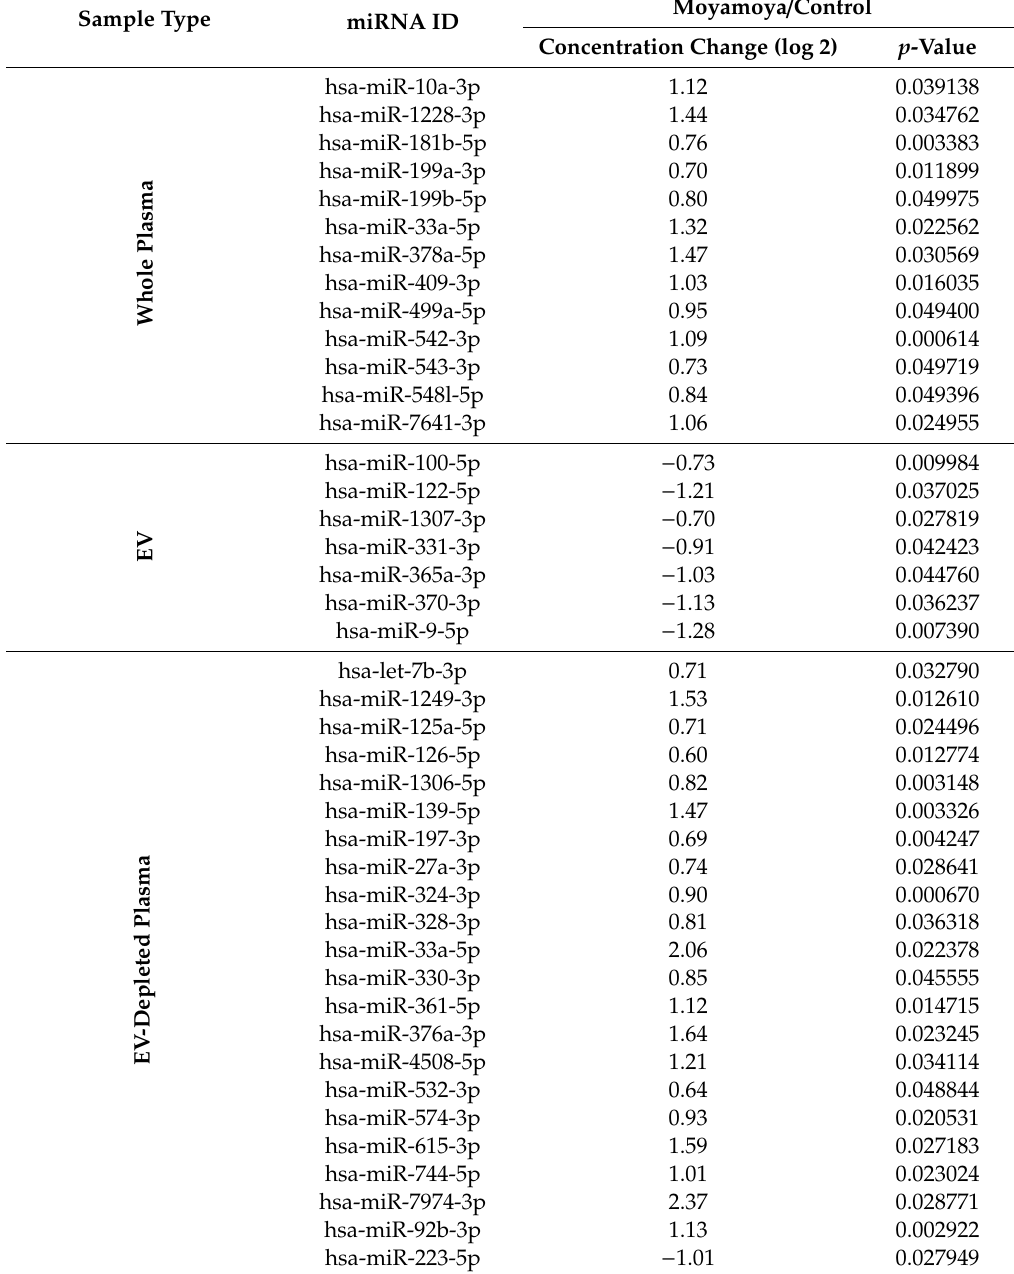
Table 2. List of moyamoya-a ff ected